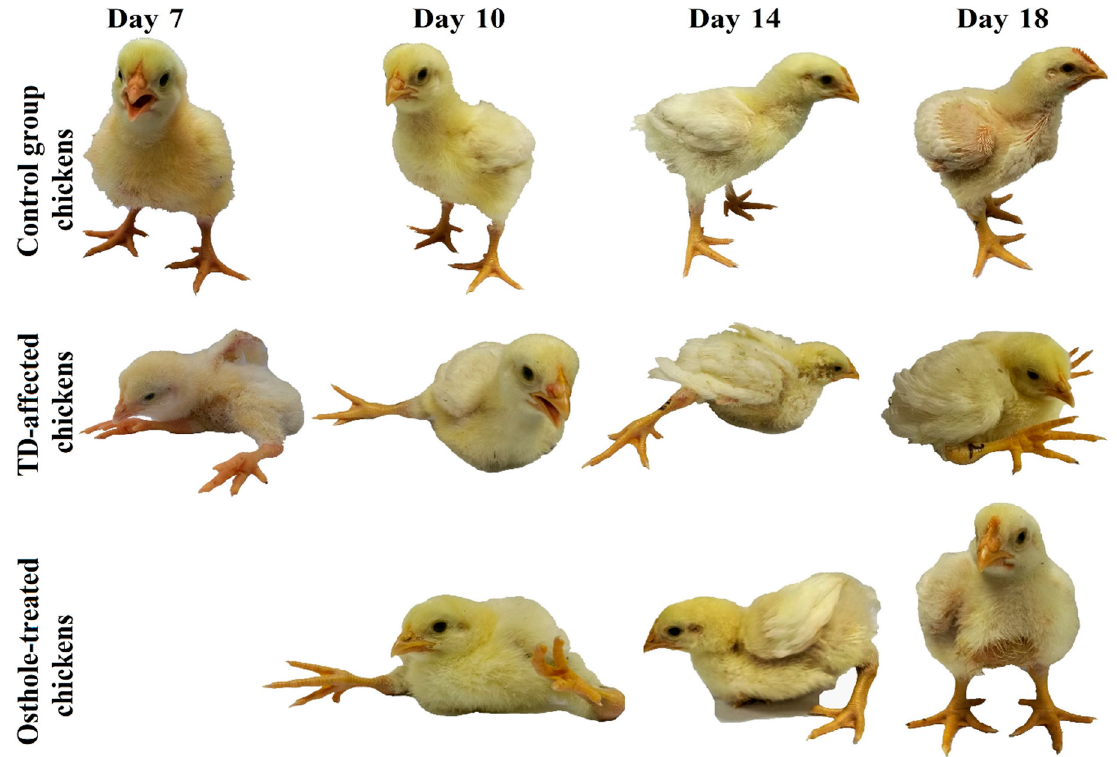
Figure 3. Birds showing characteristic clinical signs of lameness in the TD and osthole groups after thiram feeding compared to the control group. Osthole provided efficient recovery in osthole group chickens.